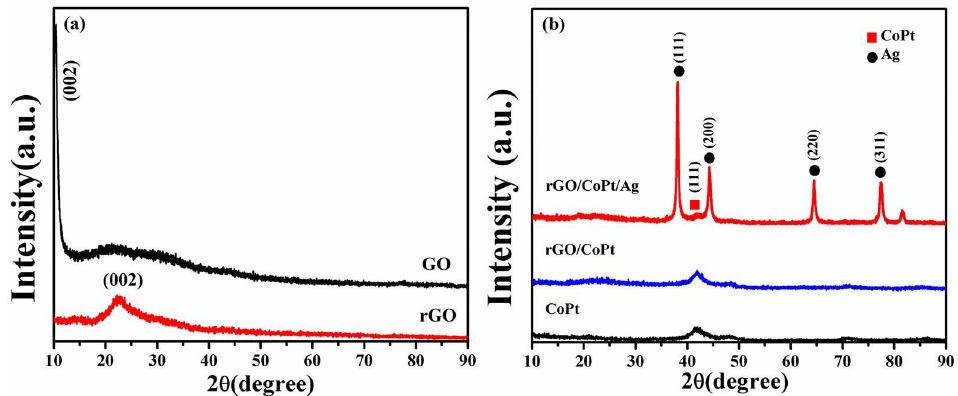
Figure 1. XRD patterns of ( a ) GO and rGO, ( b ) CoPt, rGO/CoPt, and rGO/CoPt/Ag. Raman spectra were applied to analyze the structural properties of samples. Figure 2 displays Raman spectra of CoPt, GO, rGO, rGO/CoPt, and rGO/CoPt/Ag. Figure 2 shows